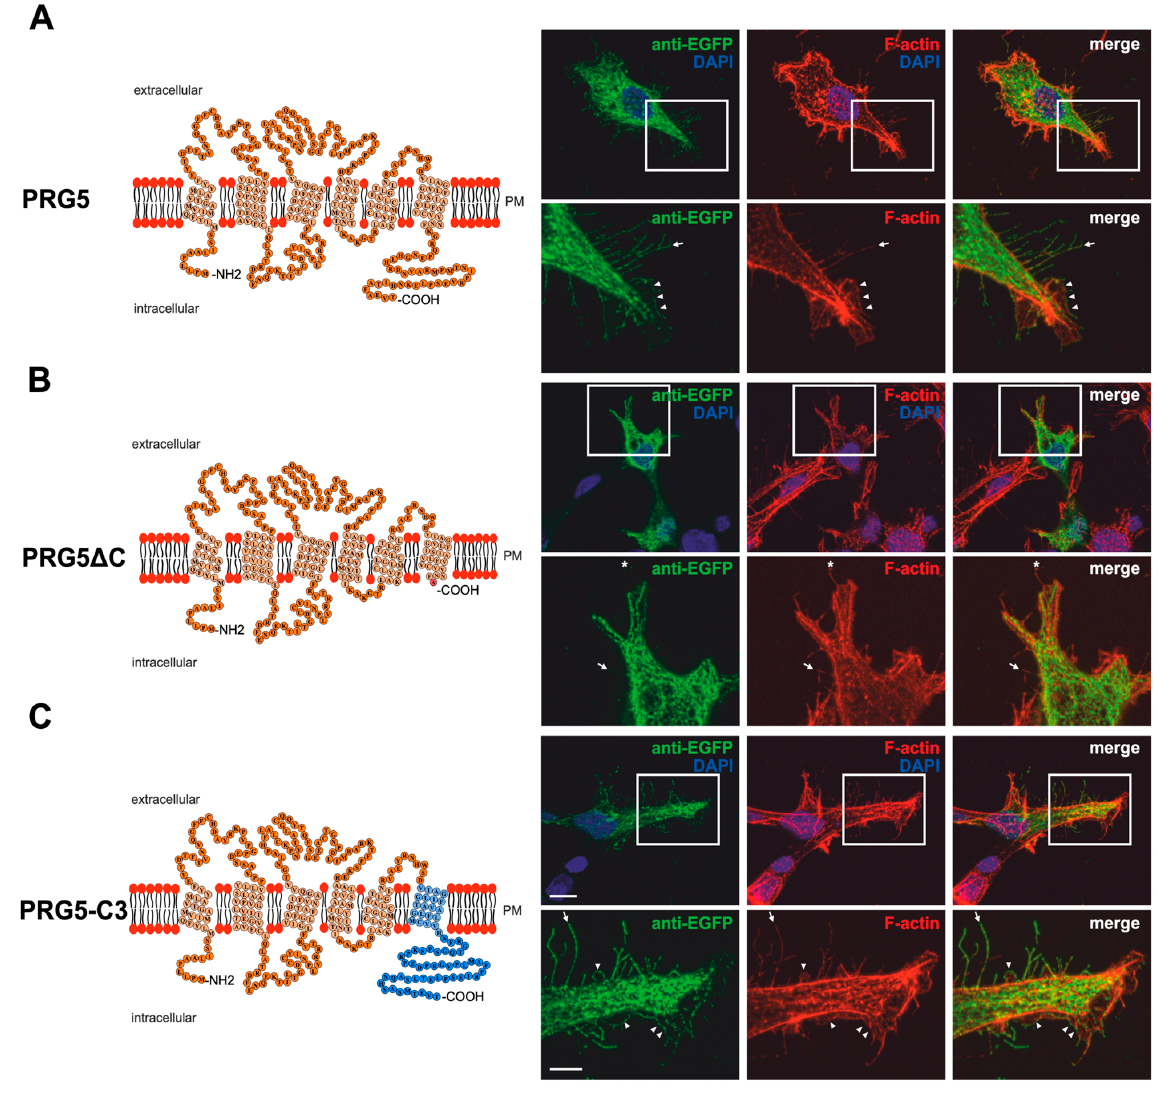
Figure 2. PRG5 and PRG3 C-terminal domains are essential for inducing morphological changes in non-neuronal cells ( A ) Left panel: Schematic depiction of PRG5. Transmembrane domains TM1-TM6 are highlighted in light orange and the C- and N-terminal regions are located on the intracellular side. Single circles represent aa (one letter code). Right upper panel: Confocal stacks of representative HEK293H cells transfected with PRG5-encoding plasmids and stained for GFP. Arrows point to filopodia identified by F-actin staining, (red, phalloidin), while arrowheads denote areas showing membrane localization. This refers also to ( B and C ). PM = plasma membrane. Lower right panel: Higher magnification of representative HEK293H cells transfected as above and indicated by white rectangles. ( B ) Left panel: Schematic depiction of PRG5 ∆ C (42 aa deleted). Upper right panel: Confocal stacks of representative HEK293H cells transfected with PRG5 ∆ C-encoding plasmids and stained for GFP. PRG5 ∆ C did not locate all filopodia as denoted by asterisks in the lower panel. Lower right panel: Higher magnification of representative HEK293H cells transfected as above and indicated by white rectangles. ( C ) Left panel: Schematic depiction of PRG5-C3. The sequence of exchanged C-terminal domain residues of PRG3 is shown in blue (aa 260–325). Upper right panel: Confocal stacks of representative HEK293H cells transfected with PRG5-C3-encoding plasmids and stained for GFP. Lower right panel: Higher magnification of representative HEK293H cells transfected as above and indicated by white rectangles. Cell nuclei were stained with DAPI (blue). The scale bar represents 10 µ m in the upper panels and 5 µ m in the lower